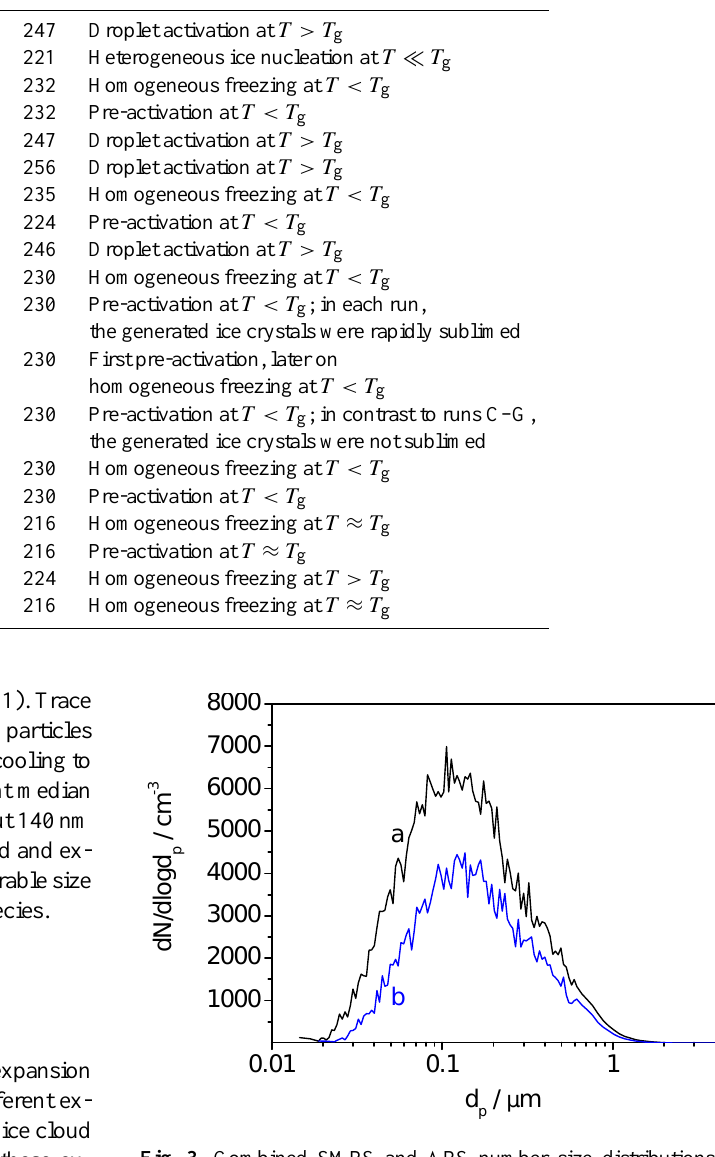
Table 1. Overview of the sequences of expansion runs conducted during five different experiments with glass-forming aqueous organic aerosol particles which are discussed in detail in the manuscript text. A specific expansion run will be referred to by combining the experiment number from the first column with the letter tabulated in the third column, e.g. run 1B, run 3H, etc. The fourth and the fifth column denote the starting temperature and the type of the expansion run, respectively. Exp. No.